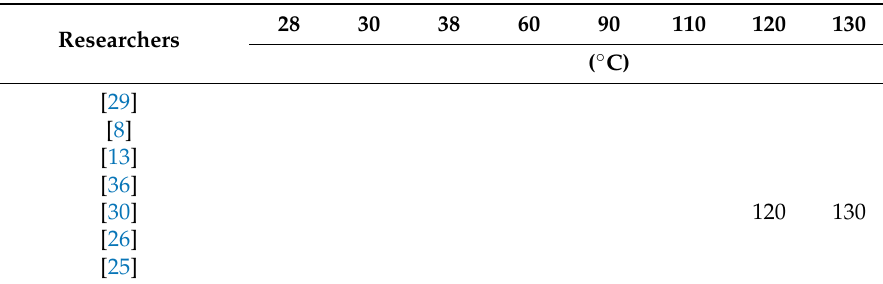
Table 3. Temperature levels of the briquetting